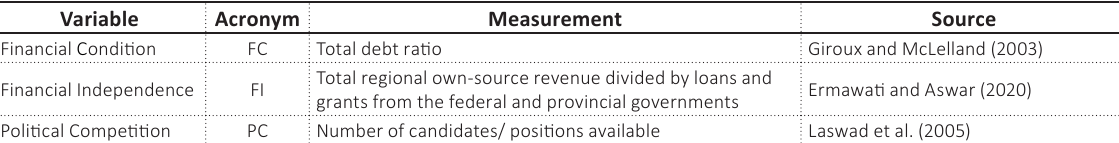
Table 2. Measurement of variables